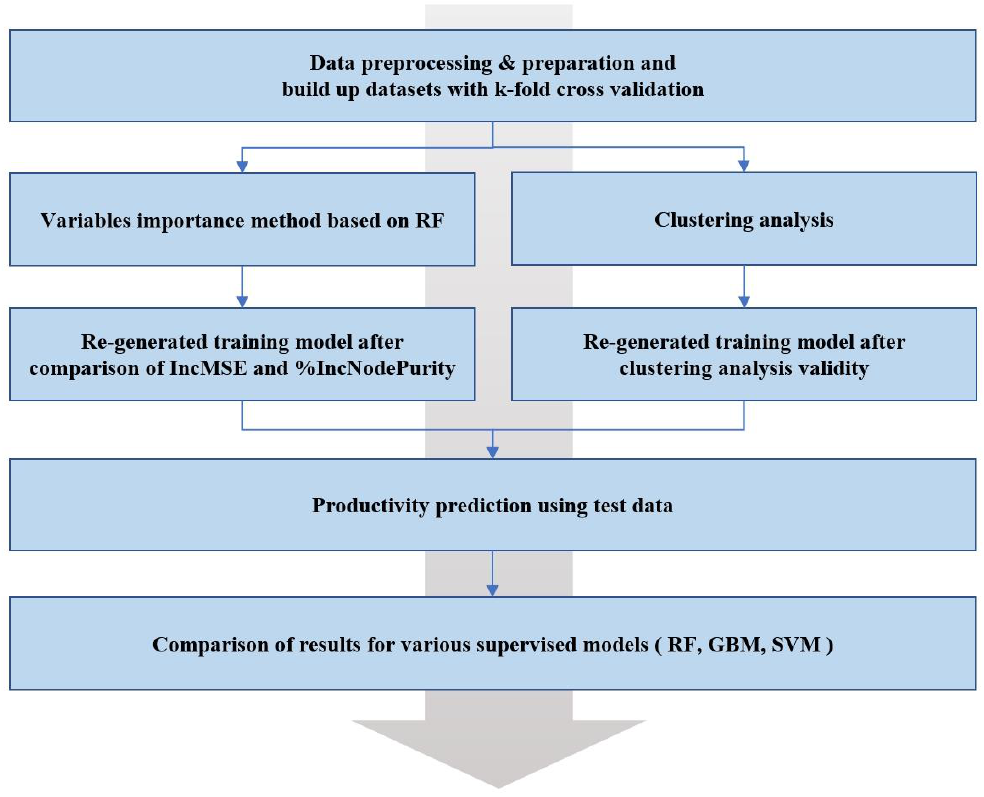
Figure 7. Workflow of productivity forecasting development model for shale gas reservoirs.